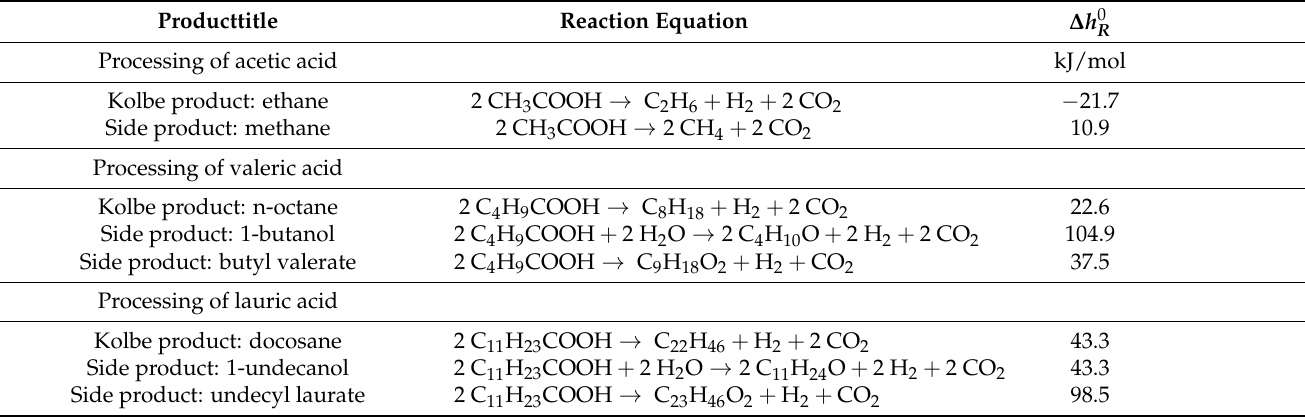
Table 2. Reactions considered for process development in the Kolbe electrolysis cell with respective enthalpy of reaction ∆ h 0 per mol of converted fatty acid at 25 ◦ C and 1.013 bar; phase states of the compounds involved are considered as given R in Table